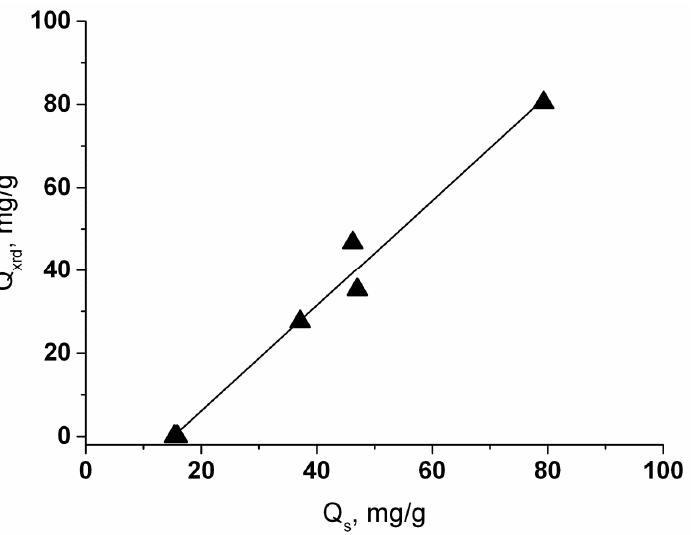
Figure 8. The dependence of the Sr 2+ content in analcime by XRD data (Q xrd ) on the sorbed Sr 2+ quantity (Q s ) in the specimen by the AAS data of filtrate solutions.